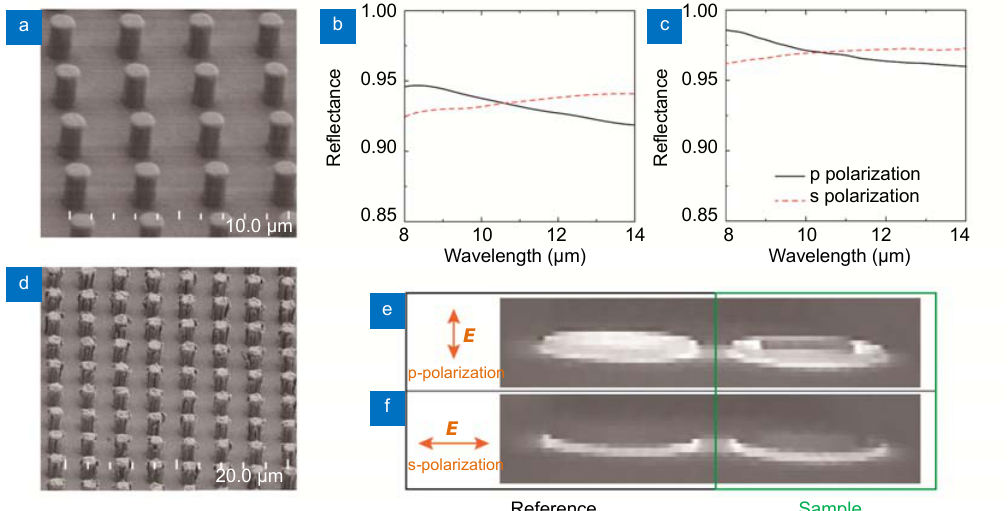
Fig. 3 | Broadband reflectance and polarimetric imaging. ( a ) Perspective view of the gold-sample. ( b ) and ( c ) FTIR spectra of the gold sample for incidence angles of 70° to 80°. The p- and s-polarizations are indicated in each panel. ( d ) Perspective view of the chromium sample. ( e ) and ( f ) Polarized infrared images of the chromium-sample and a reference sample for p - and s - polarizations. The strong emission at the circumference of the sample is from the silicon dioxide substrate (the diameter of the substrate is 2.5 cm and the structured is fabricated in a square region with a width of 1.5 cm).